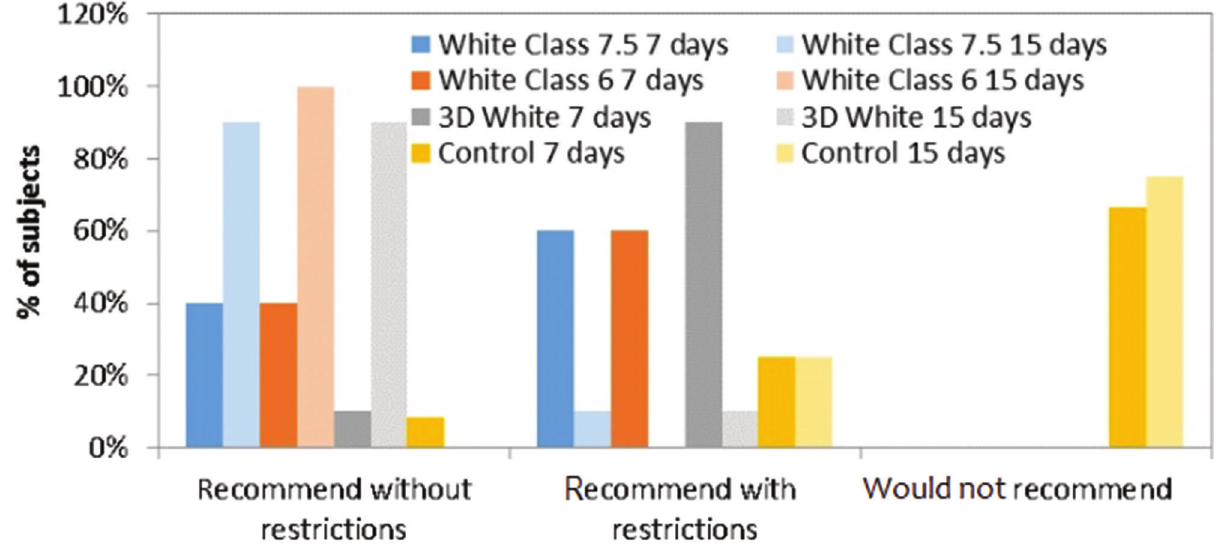
Figure 7 - Subjects ’ willingness to recommend the